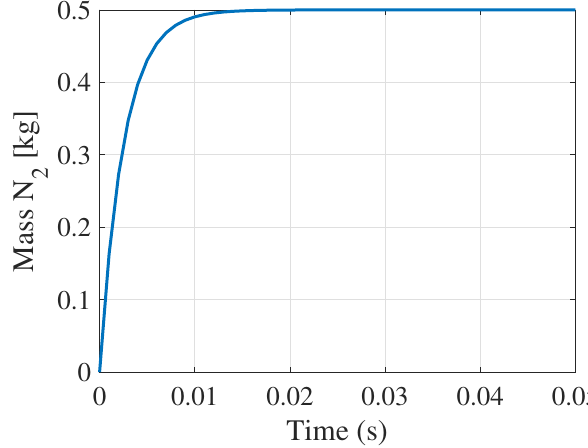
Figure 6. LQR design simulation results for m N